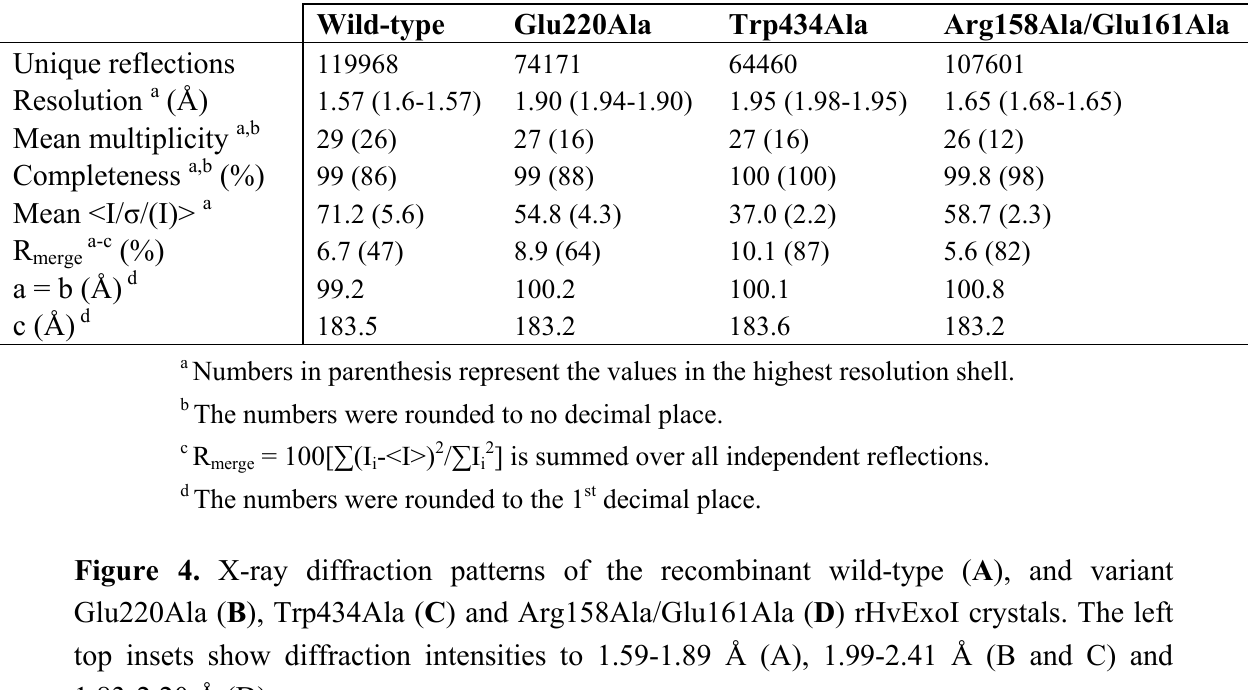
Table 1. Data collection statistics from the wild-type and variant rHvExoI crystals, calculated by the HKL2000 suite of programs.